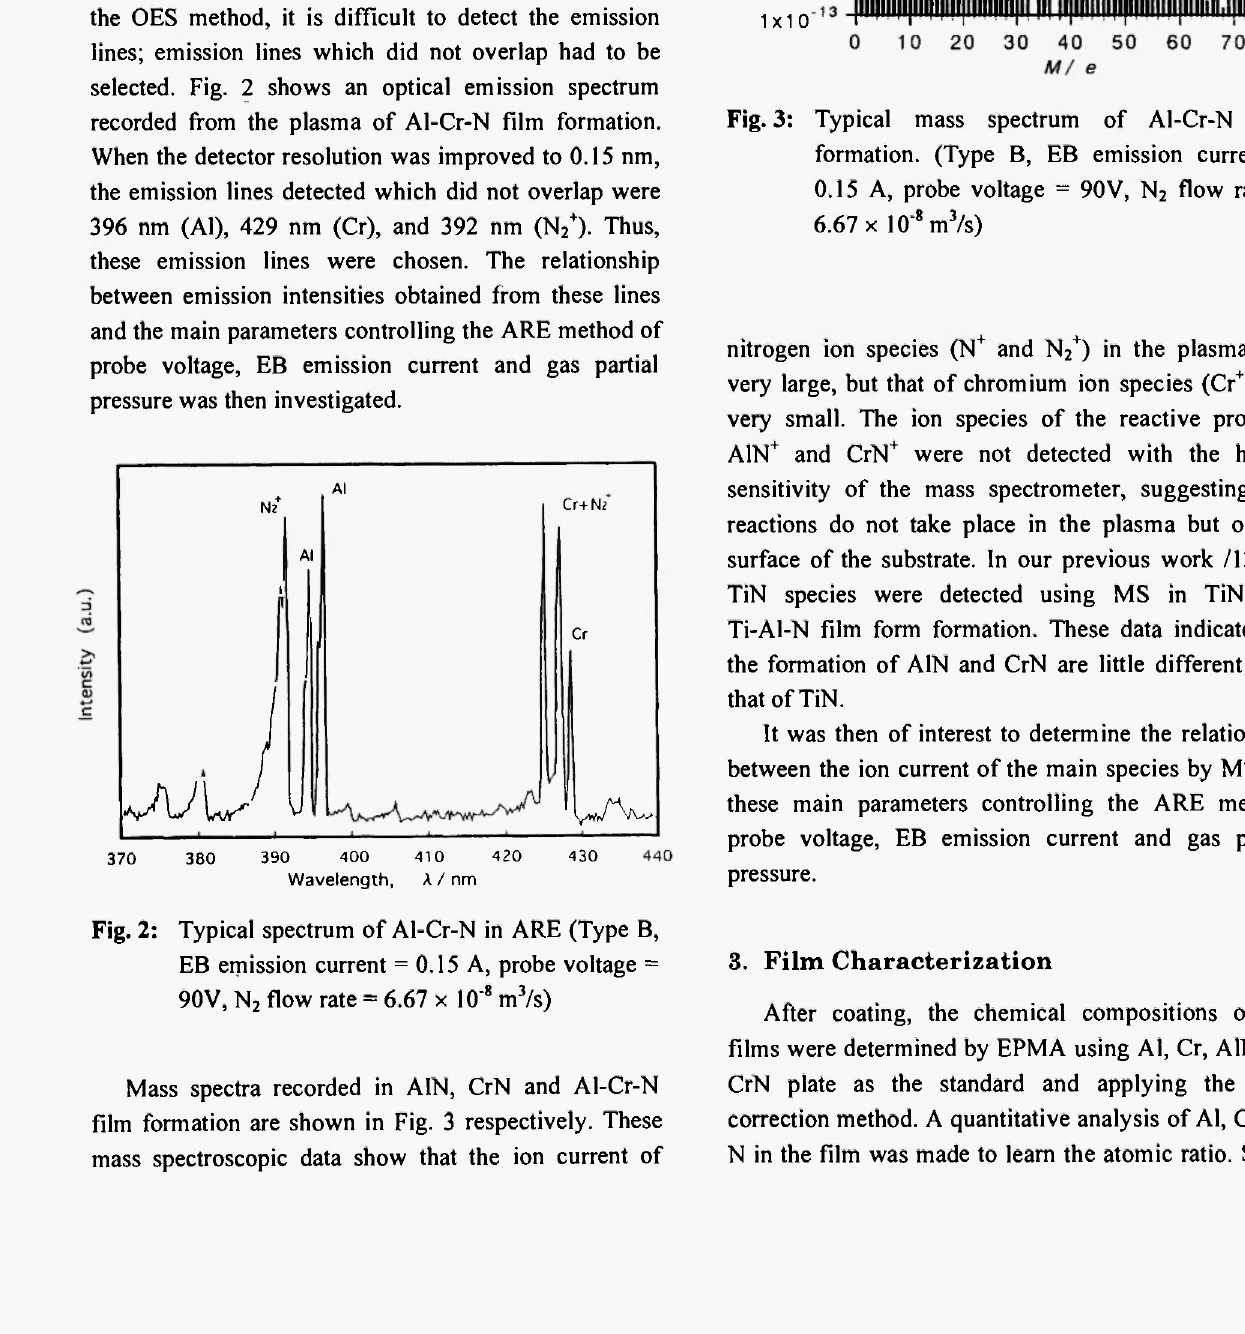
Fig. 3: Typical mass spectrum of Al-Cr-N